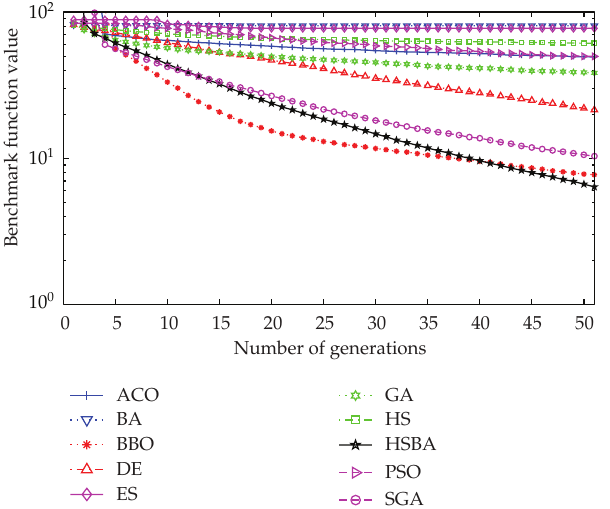
Figure 11: Comparison of the performance of the different methods for the F11 Schwefel 2.22 function.